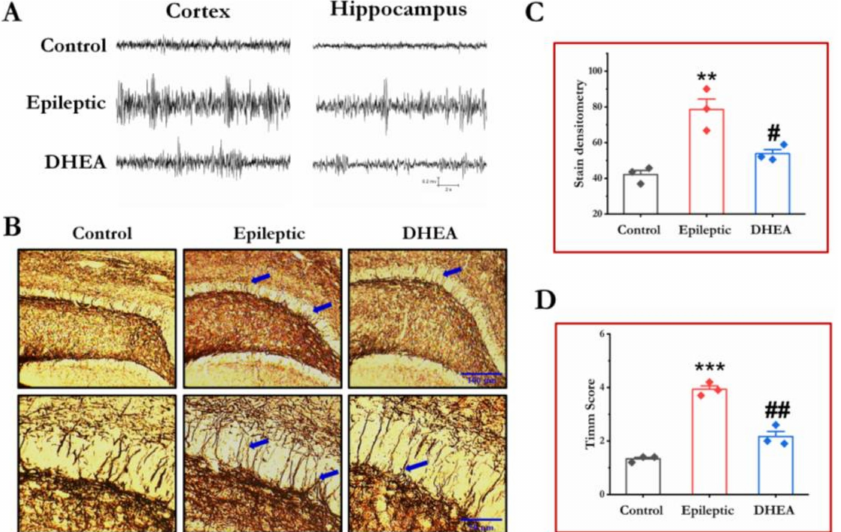
Figure 2. Representative EEG samples of 20 s duration from the cortex and hippocampus of control, epileptic, and DHEA-treated rats ( A ). Timm’s stating images showing Mossy Fibers (indicated by arrows) in the dentate gyrus (DG) region of rats ( B ). Quantitative data analysis indicates lower stain density ( C ) and Timm’s score ( D ) in DHEA-treated rats with respect to epileptic rats. ** p ≤ 0.01, *** p ≤ 0.001, significantly different from controls; # p ≤ 0.05, ## p ≤ 0.01, significantly different from epileptic rats. ANOVA F values for stain densitometry: 17.659 and Timm’s score: